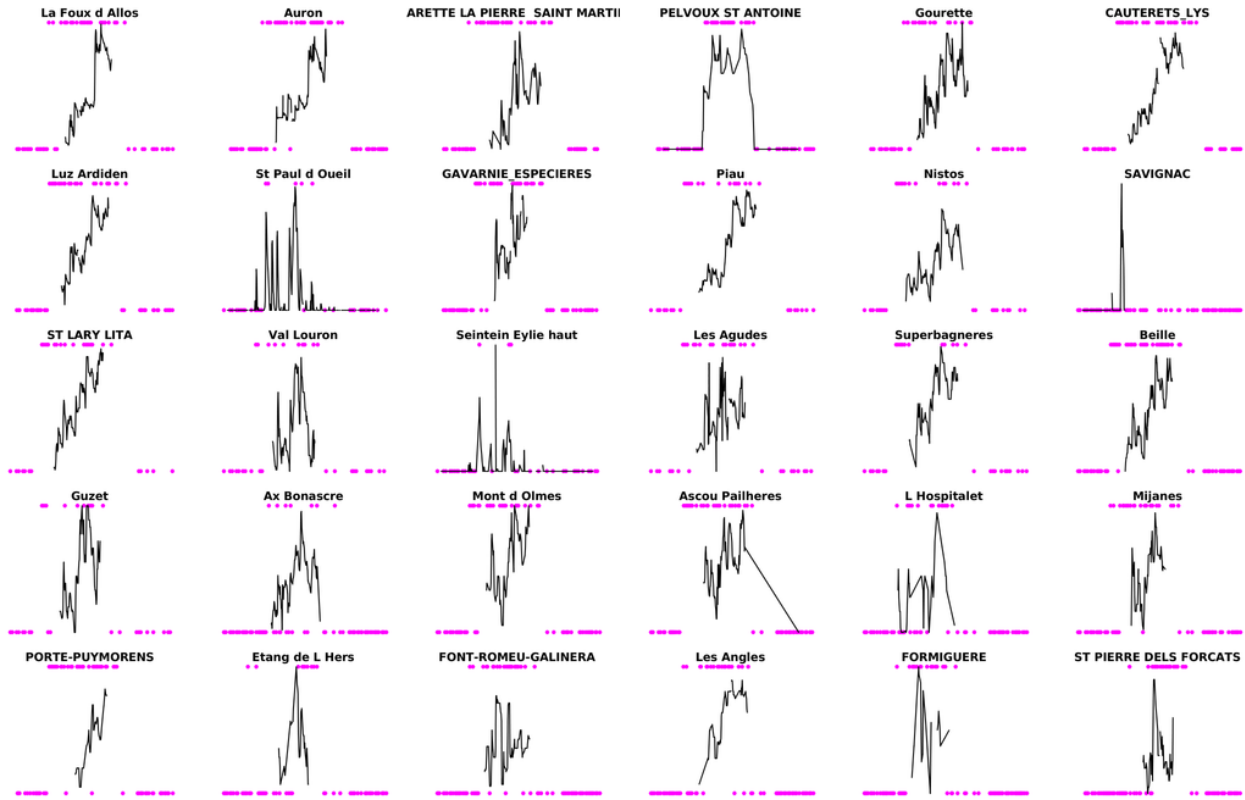
Figure B4. Magenta dots: snow presence (a) or absence (b) in the Theia snow collection. Black line: snow depth time series.